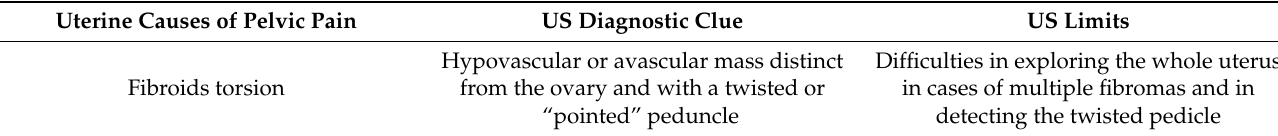
Table 10. Fibroid torsion US diagnostic